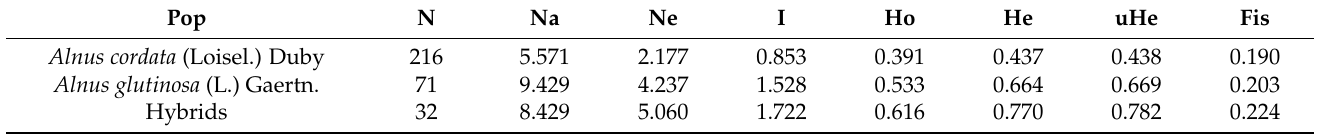
Table 2. Genetic diversity indices for the 319 individuals of A. cordata , A. glutinosa and hybrids. Pop N Na Ne I Ho He uHe Fis Alnus cordata (Loisel.) Duby 216 Alnus glutinosa (L.) Gaertn.